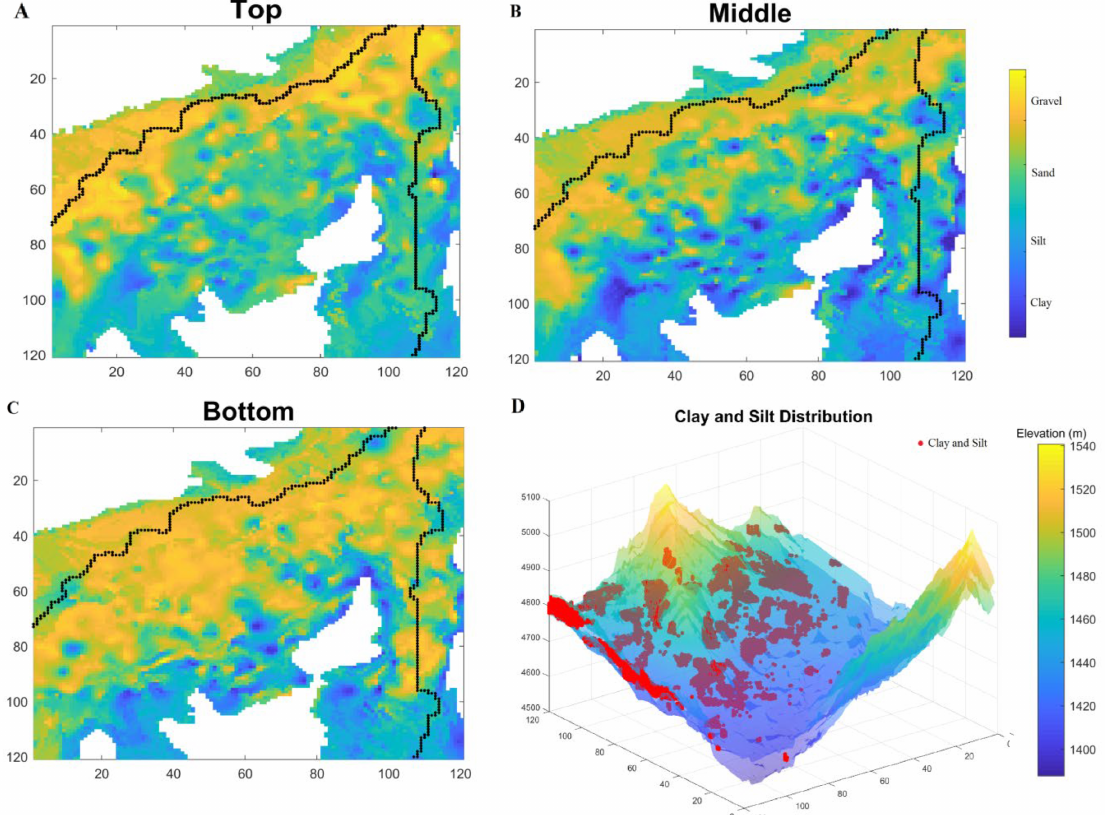
Figure 3. Figure ( A – C ) show the estimated material map for layers near the top, middle, and bottom portions of the aquifer using 3-D Kriging interpolation. The aquifer material is more conductive (sand and gravel) near the South Platte River (shown along the north of the study area in black squares). Figure ( D ) shows the 3-D clay distribution in the aquifer.